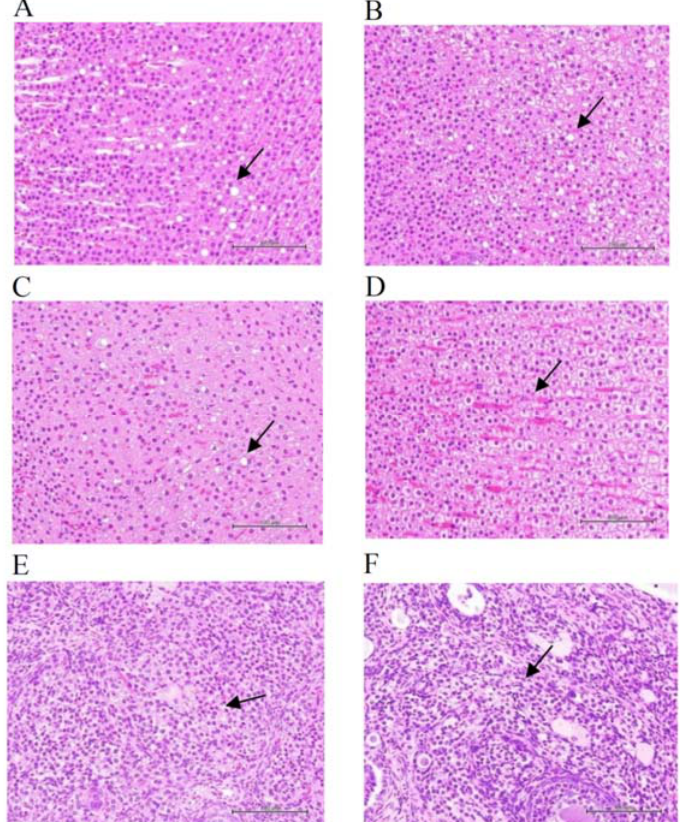
Figure 3. Histopathological changes of the adrenal glands of male and female rats and ovaries of female rats receiving high-dose ACP for 90 days. Arrows indicate adrenal glands of zona fasciculate having multifocal cholesterol hypertrophy and lipidosis: in the male rats of ( A ) the control (animal #111) and ( B ) high-dose ACP-treated (animal #137) groups and the female rats of ( C ) the control (animal #169) and ( D ) high-dose ACP-treated (animal #186) groups. Arrows indicate multifocal cholesterol hypertrophy of interstitial glands in ovaries of ( E ) the control (animal #169) and ( F ) high-dose ACP-treated (animal #199) female rats. In the male rats, the mean scores of cholesterol hypertrophy and lipidosis were 2.0 ± 0.0 and 0.6 ± 0.9 in the control group, and 2.3 ± 0.6 and 0.8 ± 1.0 in the high-dose ACP-treated group, respectively. In the female rats, the mean scores of cholesterol hypertrophy and lipidosis were 1.4 ± 0.9 and 0.2 ± 0.6 in the control group and 2.1 ± 0.8 and 0 in the high-dose ACP-treated group, respectively. The mean scores of multifocal cholesterol hypertrophy of interstitial glands in the ovary were 0.2 ± 0.6 and 0.5 ± 1.0 in the control and high-dose ACP-treated groups. The scores in histopathological changes between the control and high-dose ACP-treated animals were not statistically different as analyzed by the Student’s t -test. H&E stain; 400 ×